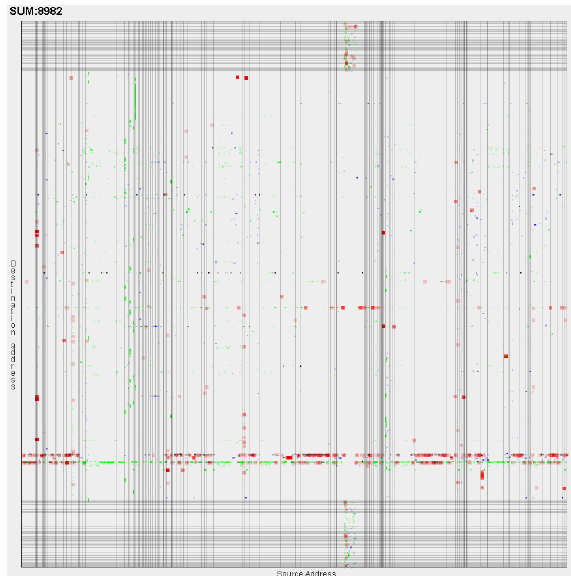
Figure 5: UnEqual Scaling Alert Matrix which em- phasize anomalous warning events.